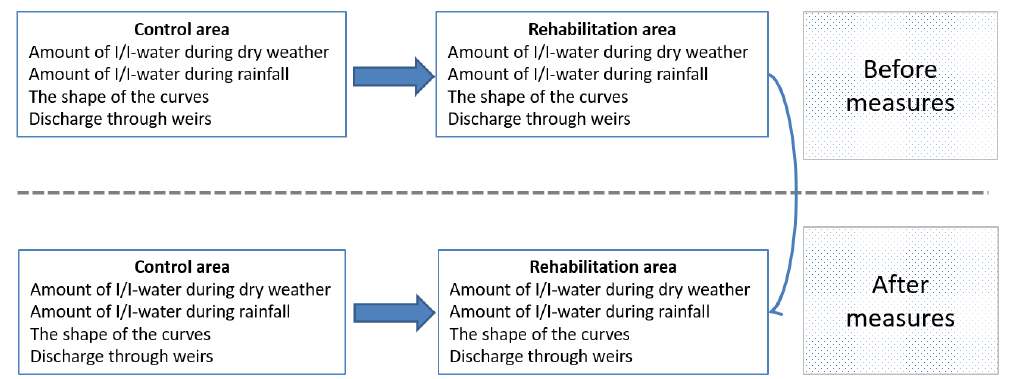
Figure 3. Schematic drawing of the method used to investigate the impact of measures in the rehabilitation areas.